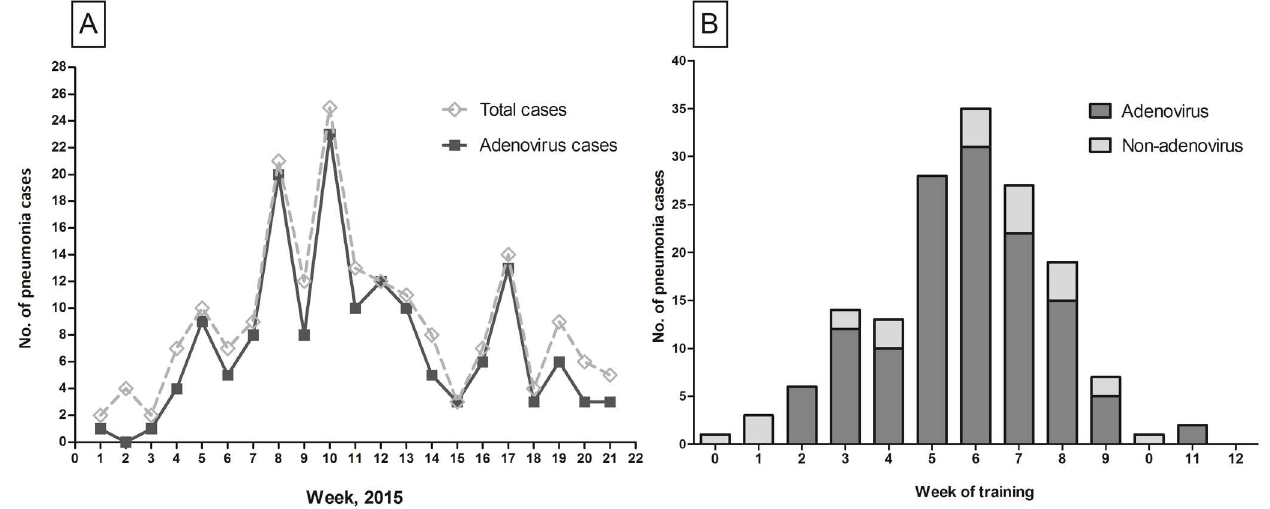
Fig 2. (A) Numbersof patients with community acquiredpneumonia and adenovirus pneumonia by week duringJanuary–May 2015. (B) Number of patients with adenovirus pneumonia (HAdV) and non-adenovirus pneumoniaby military trainingweek amongnewly recruited trainees( (cid:20) 12 weeks of trainingor service